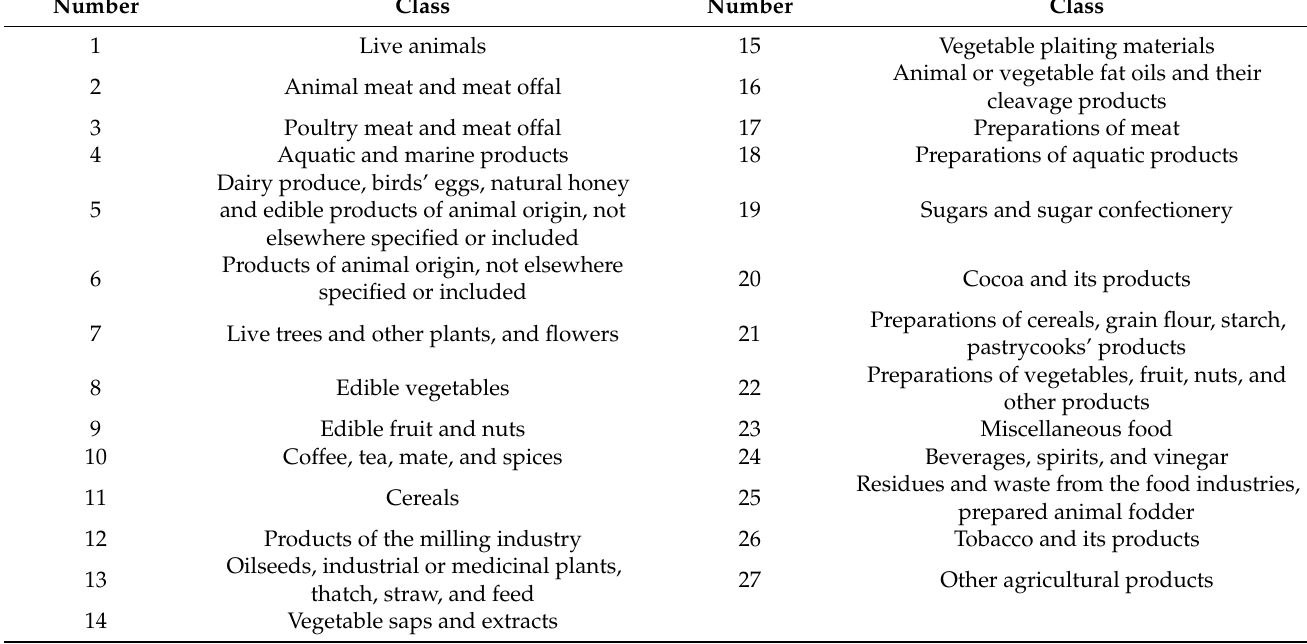
Table A1. The agricultural product